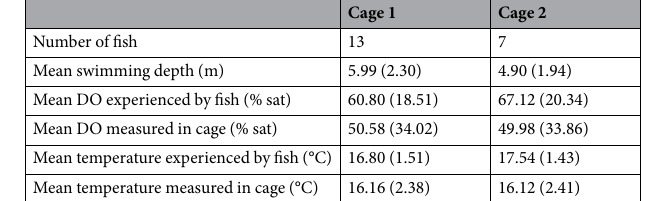
Table 2. Data overview. Standard deviations shown in brackets. To account for the fact that some stationary string tags malfunctioned during parts of the study period, cage water column data were grouped into 2.5 m depth bins and each data point weighted by the inverse of the total number of observations for its depth bin for the calculation of means and standard deviations.